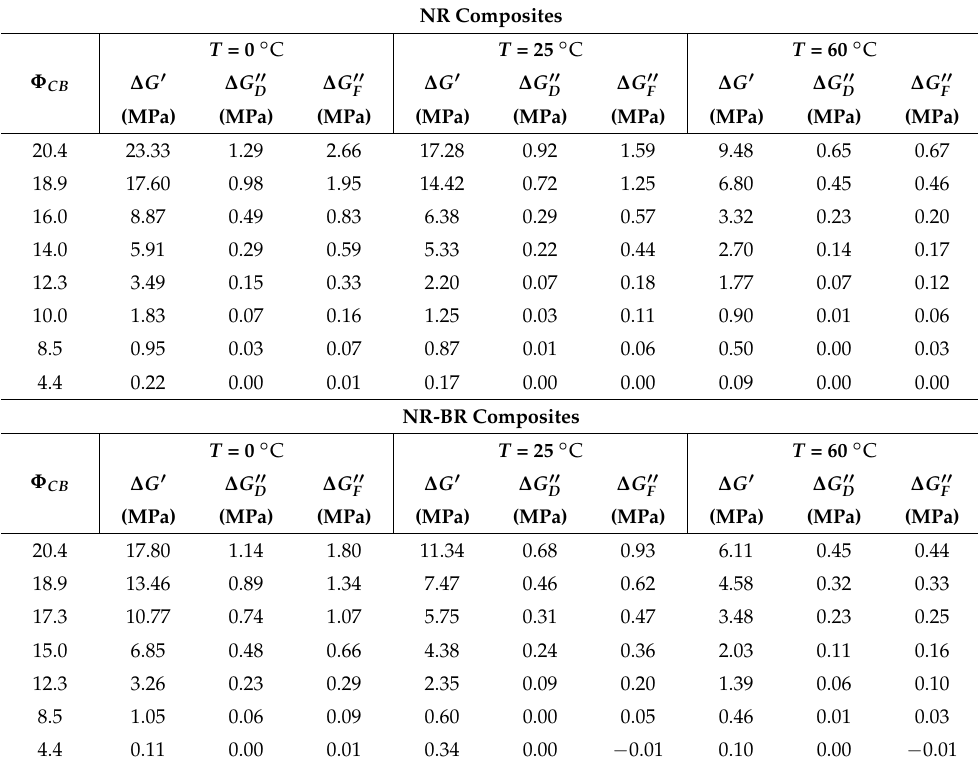
Table 1. Fit parameters for filler network related contribution to reinforcement ( ∆ G (cid:48) ) and dissipation ( ∆ G (cid:48)(cid:48) , ∆ G (cid:48)(cid:48) D F